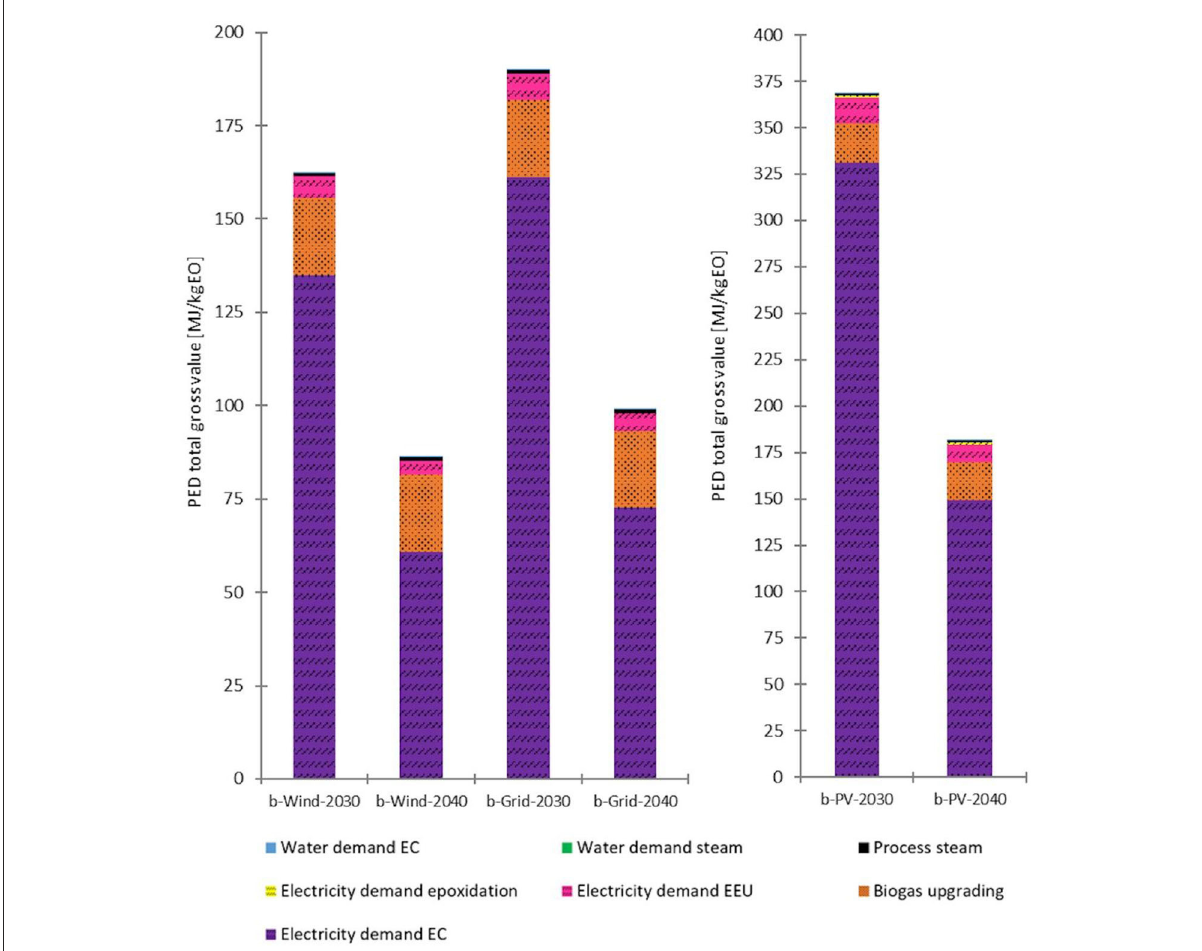
FIGURE9 Detailed PED of the 2030 and 2040 biogenic CO 2 (short: b) scenarios with different energy supplies. Left: wind power and grid-mix scenarios. Right: PV power scenarios. Source: own data and illustration.